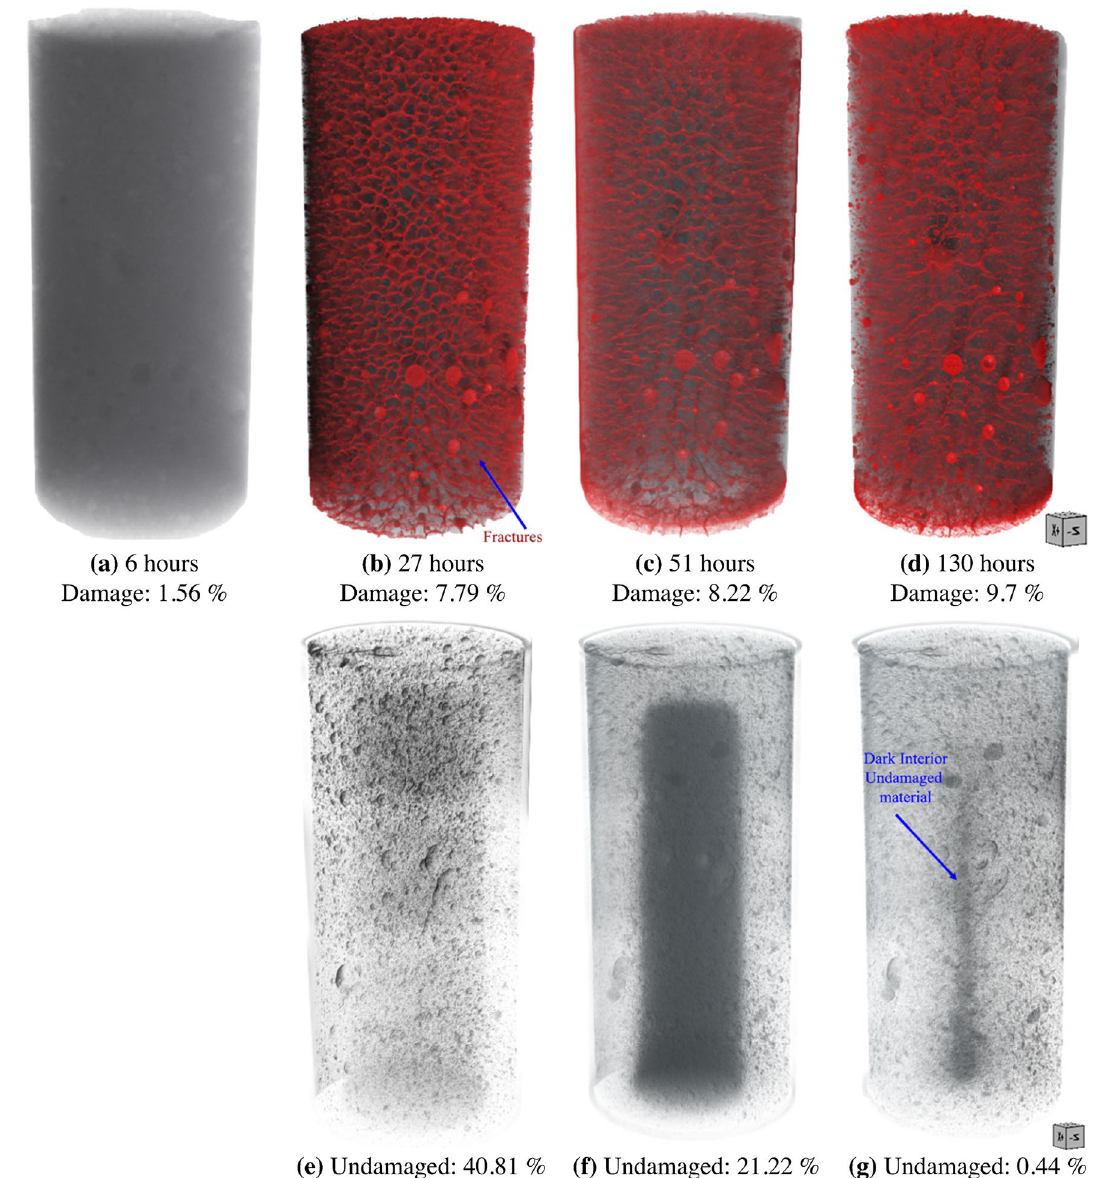
Figure 4. 3D visualizations of the interior and drying shrinkage deformation of a specimen with 20% montmorillonite distributed within the framework during the experimental dehydration period, where ( a – d ) shows the growth of the crack network in 3D, and ( e , f ) shows the reduction of the undamaged material zone (shrinking dark columns) and evolution of the drying front. The undamaged data for the initial sample is not shown as 93% of the sample remains undamaged. Data are visualized with Dragonfly Pro software, Version 2020.2 for [Windows] from ORS 13 and 2b, and the MSCS experimental results seen in Figs. 1c and 2c. In order to study sample CB, a parameter study was conducted to determine the sensitivity of the fracture patterns to changes in the material properties of the clay and mortar. The parameter study focused on the CB geometry since it exhibited the most complex crack patterns. By varying a single parameter from a set of base case parameters, the impact of each parameter on the fracture pattern was explored. The numerical models included eight different parameters that were varied: the water diffusivity and critical stretch of the mortar, clay, and interfaces as well as the shrinkage of the clay and mortar. The diffusivity, critical stretch, and shrinkage were all material parameters that varied the most between the two materials (the clay and the cement matrix) and during hydration, and were therefore expected to have the most significant effect on the resulting crack networks. Images from the PD models are presented in Fig. 7. Damage to a node which discretizes the material (see Equation (12) in Supplementary Note 12) occurs when a PD bond breaks, resulting in a loss of connectivity between the corresponding nodes that make up the bond. The damage at the node is the proportion of broken bonds connected to the node compared to the original number